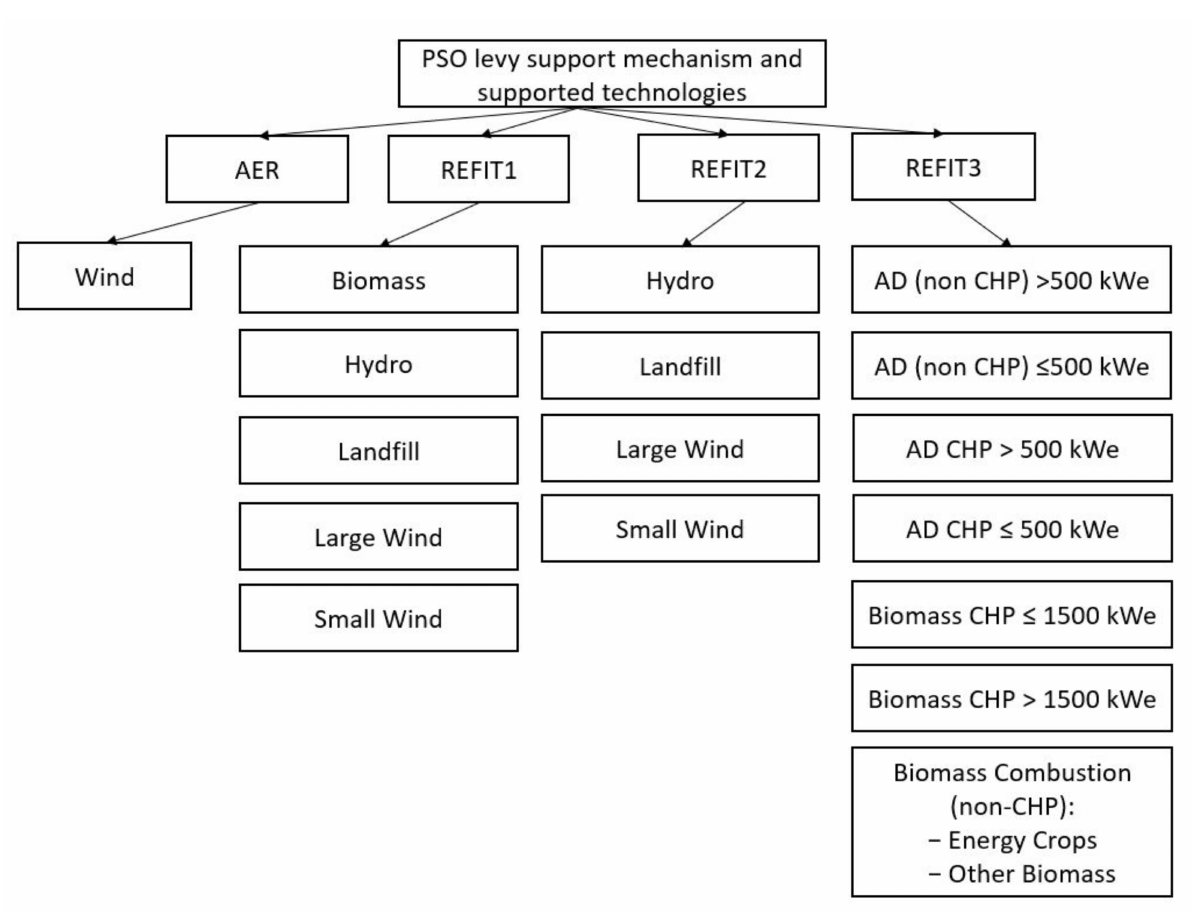
Figure A1. Irish PSO levy support mechanism and supported technologies (created by the authors, based on